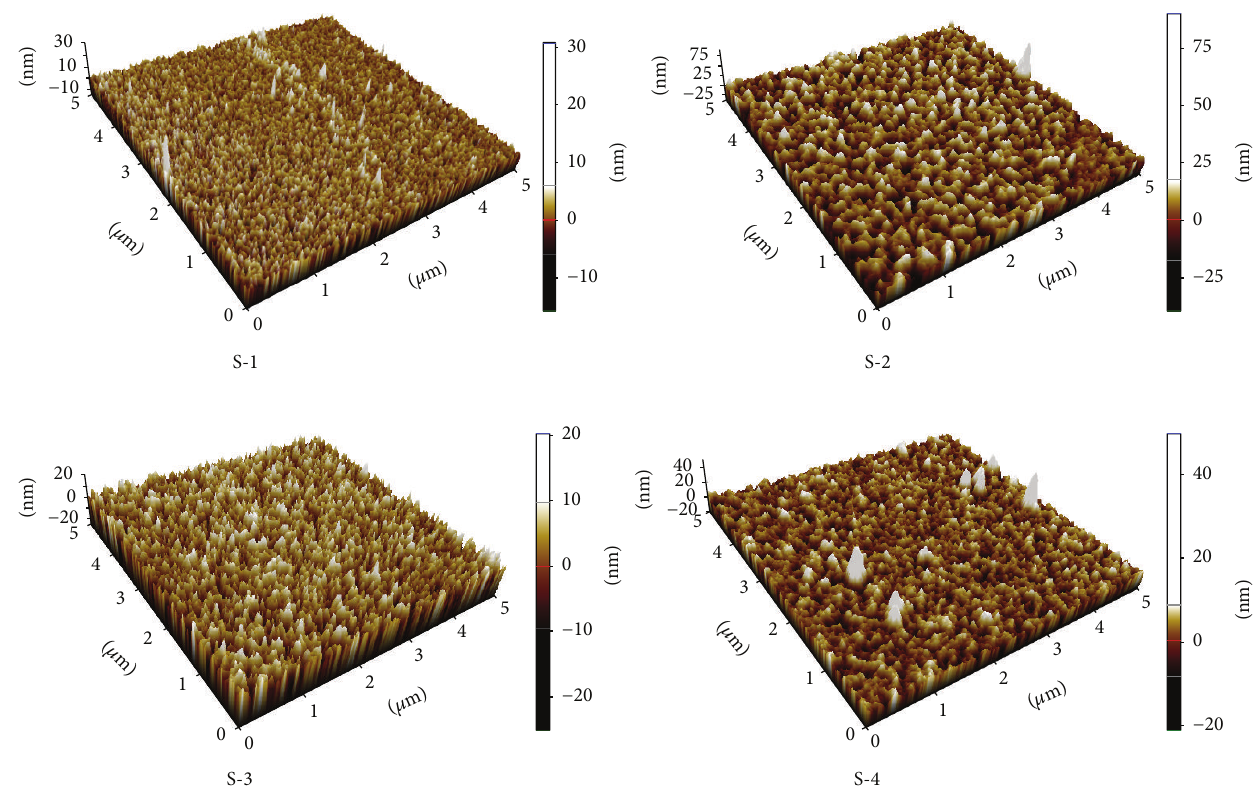
Figure 5: AFM images of the Al-doped CdO thin films of S-1, S-2, S-3, and S-4